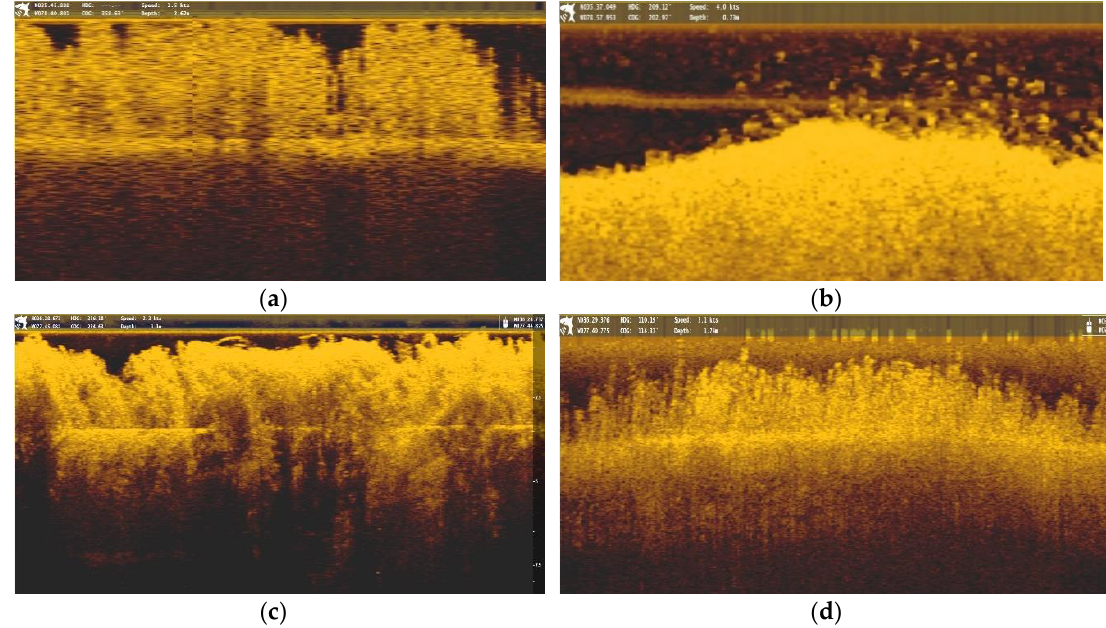
Figure 14. Example hydroacoustic images of each of the weed classes: ( a ) Hydrilla , ( b ) Other, ( c ) Cabomba , and ( d ) Coontail.